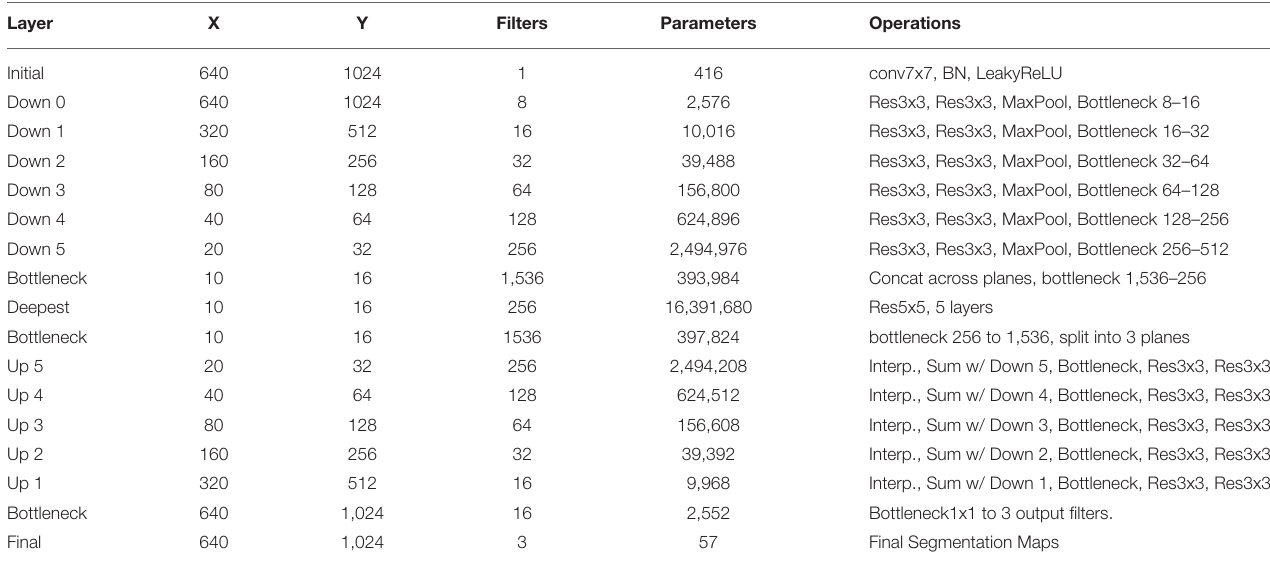
TABLE 1 | A description of the multi-plane UResNet architecture used in this work. Filters Parameters